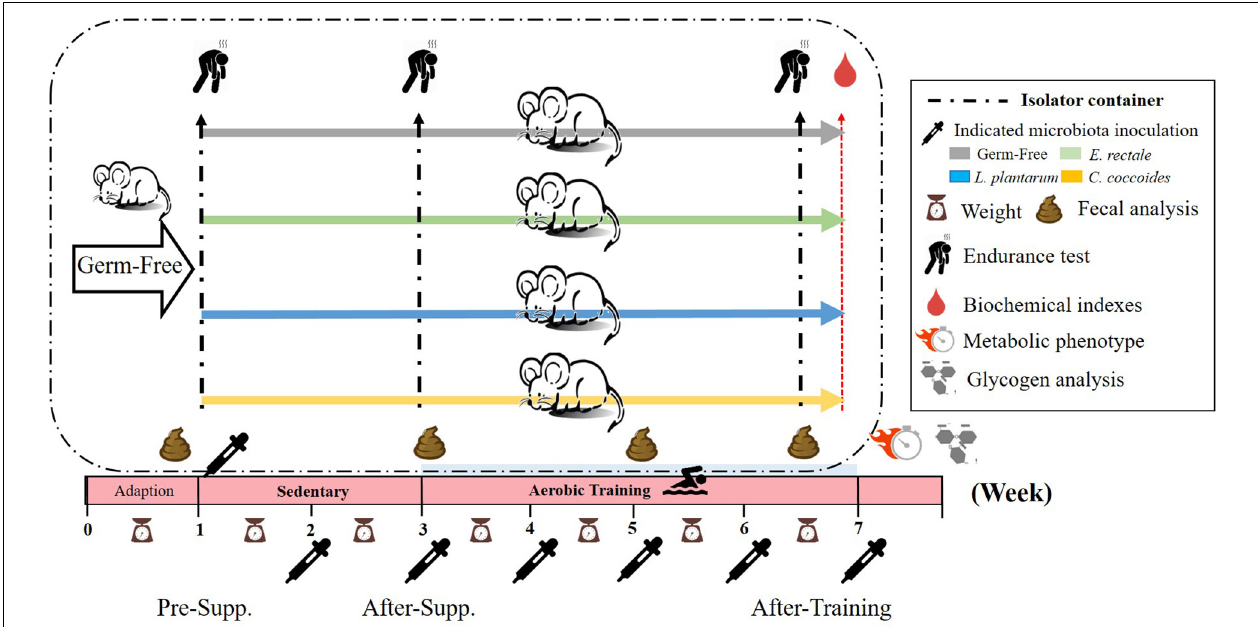
FIGURE 1 | Experimental designs to assess the exercise-capacity and physiological-adaption effects on gnotobiotic animals. The GF animals were randomly assigned, inoculated, and colonized with the indicated 4 groups (GF, E. rectale , L. plantarum TWK10, and C. coccoides ). Fecal samples were regularly analyzed and the physical capacities and related biochemistries were assessed within the test duration. The metabolic phenotype, body compositions, and glycogen were measured at the end of study. Supp.,